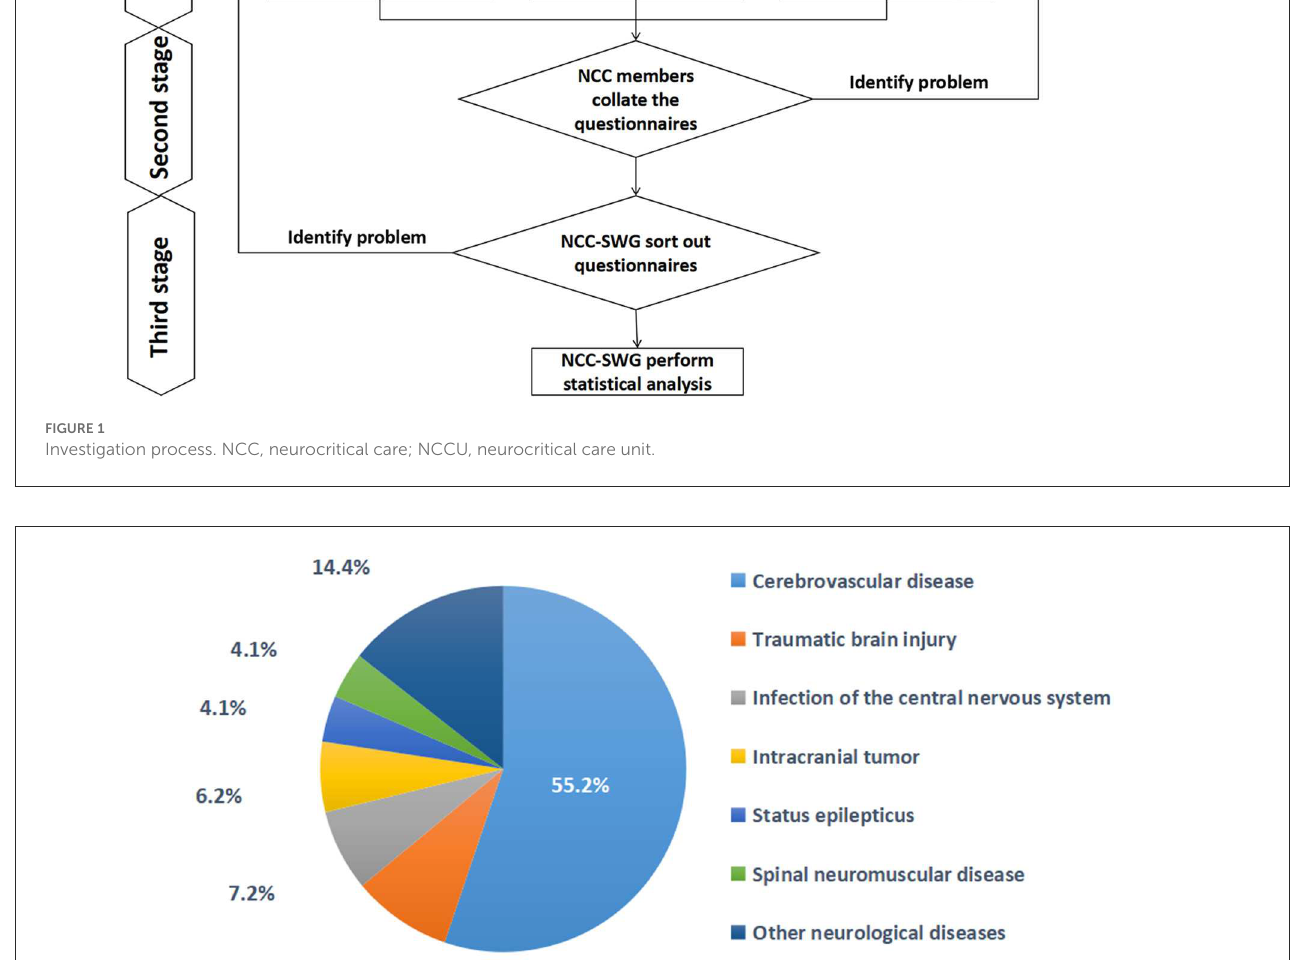
selected, and the annual data were estimated according to the formula of monthly average sum/4 ∗